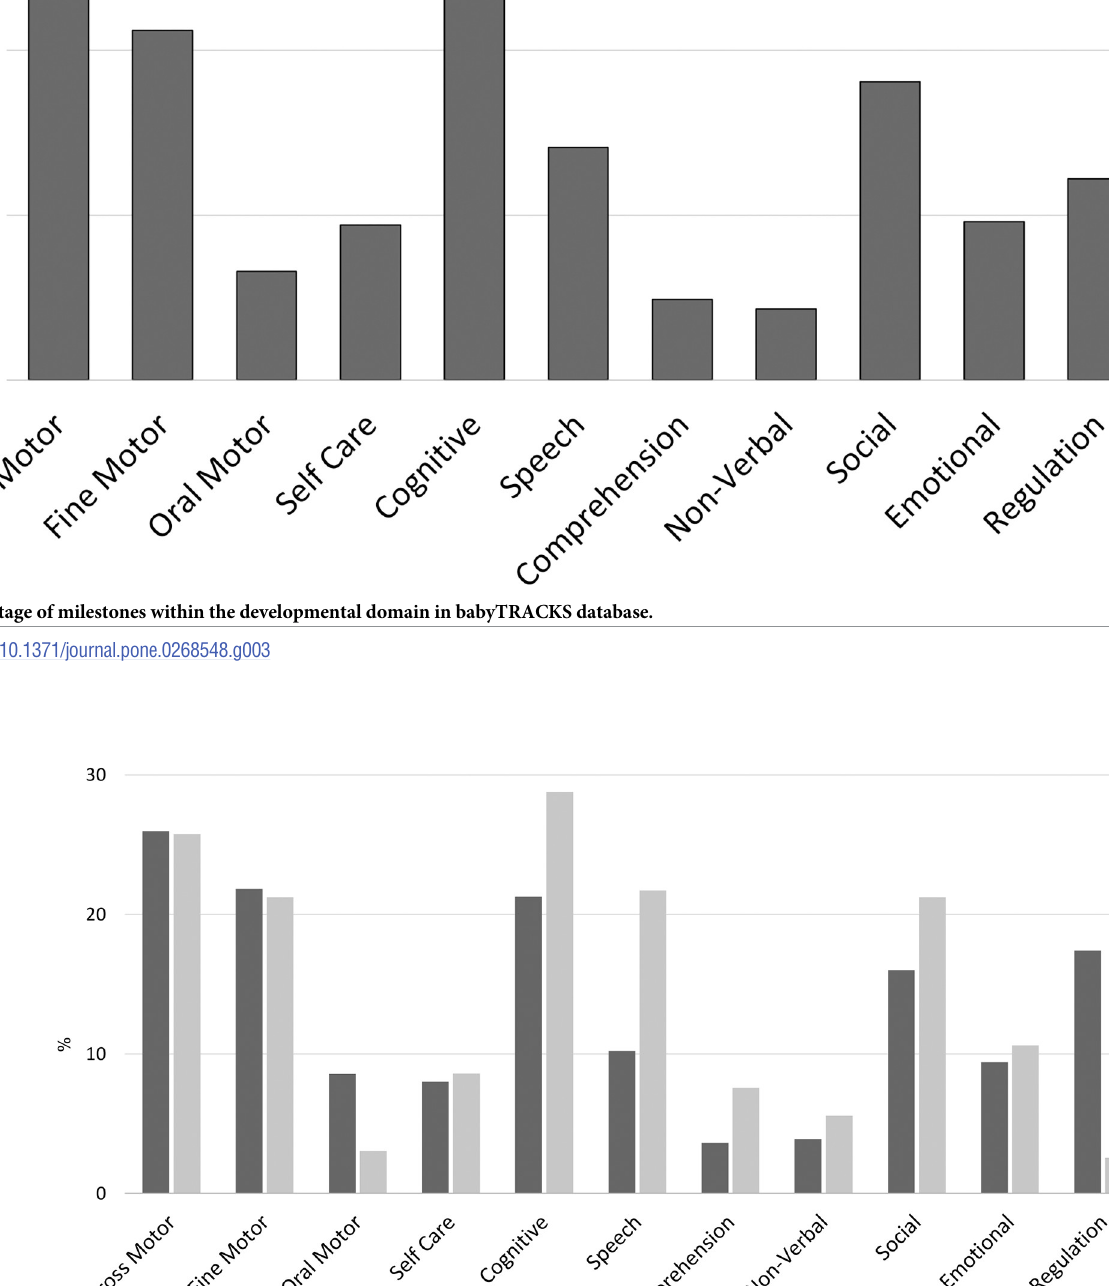
PLOS ONE | https://doi.org/10.1371/journal.pone.0268548 May 26,